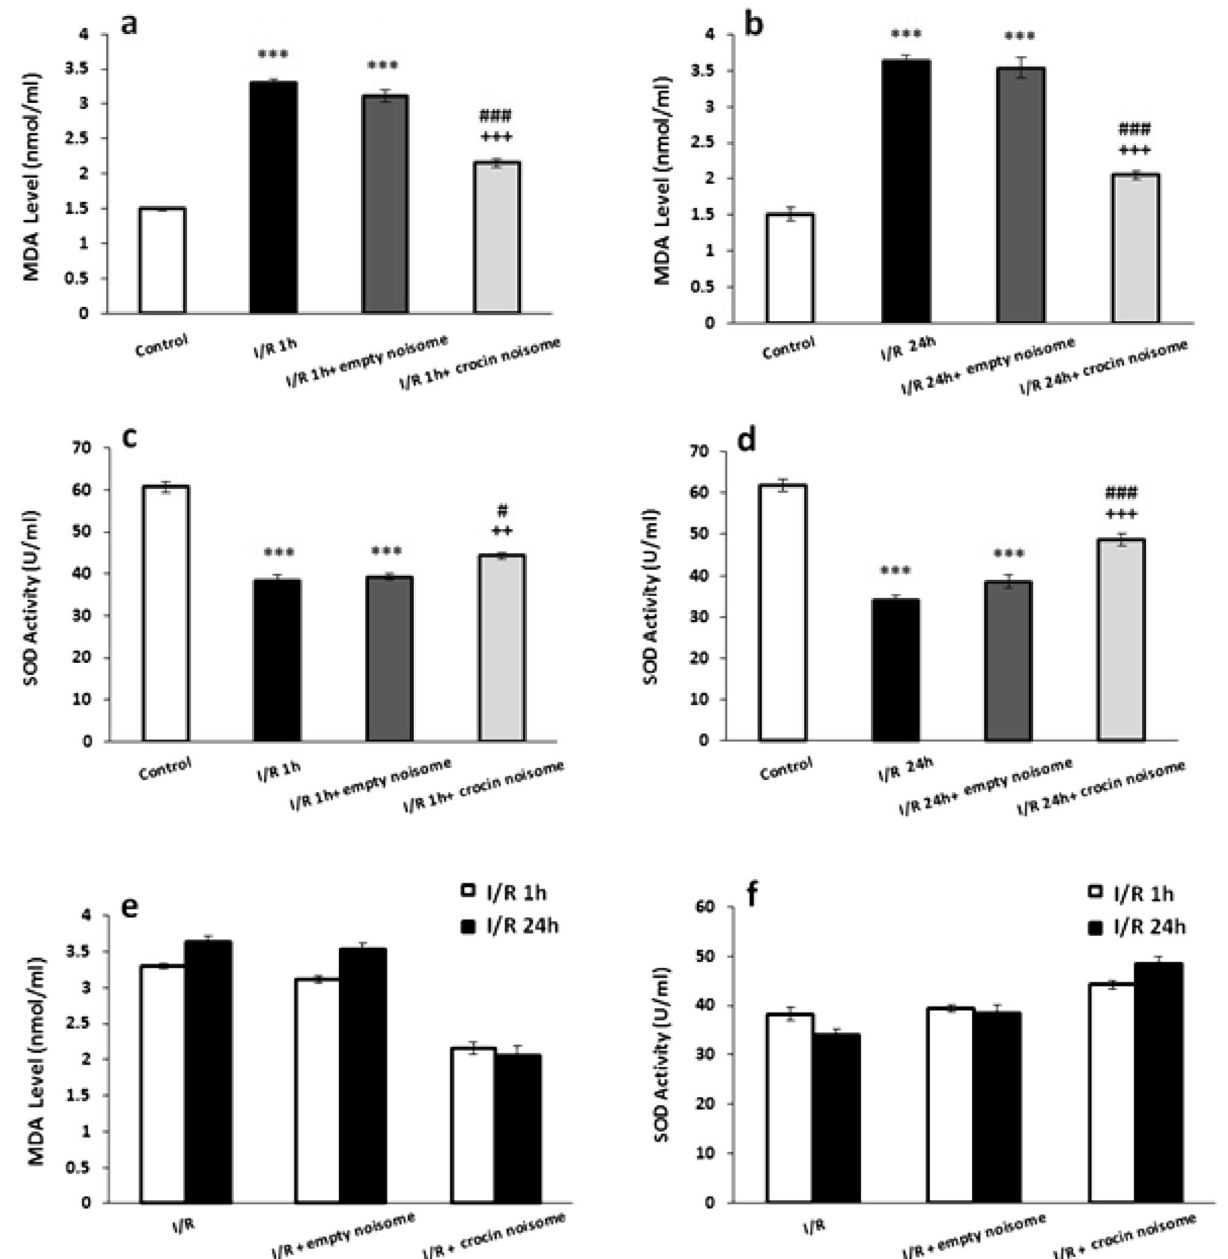
Figure 5. The effect of crocin-loaded nanoniosomes on ( a ) 1 h after I/R-induced changes in MDA serum level, ( b ) 24 h after I/R-induced changes in MDA serum level, ( c ) 1 h after I/R-induced changes in SOD serum level, ( d ) 24 h after I/R-induced changes in SOD serum level ( e ) comparison ischemia-induced changes followed by 1 h and 24 of reperfusion in MDA serum level and ( f ) comparison ischemia-induced changes followed by 1 h and 24 of reperfusion in SOD serum level. Data presented as mean ± SEM. ***P < 0.001 versus control group; ++ P < 0.01 and +++ P < 0.001 versus I/R group; # P < 0.05 and ### P < 0.001 versus I/R + empty niosome